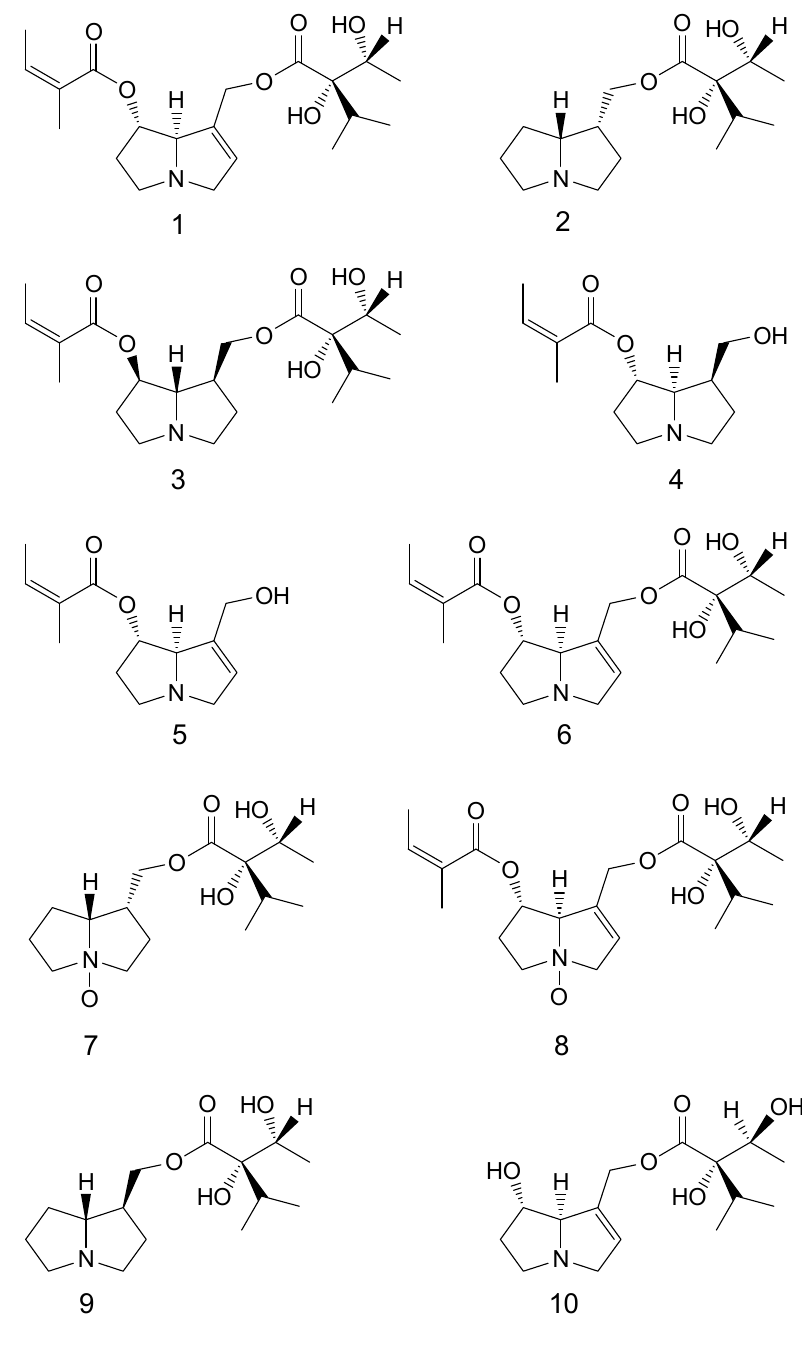
Figure 1. Structures of compounds 1 – 10